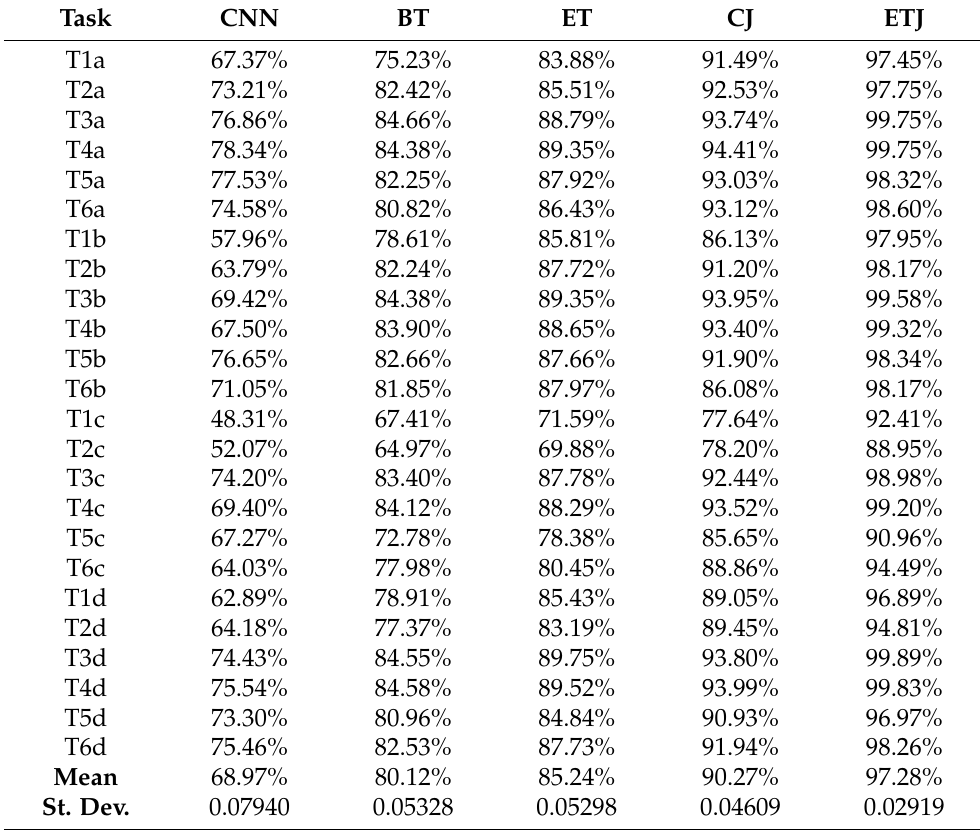
Table 5. The diagnosis accuracy of different tasks corresponding to the different